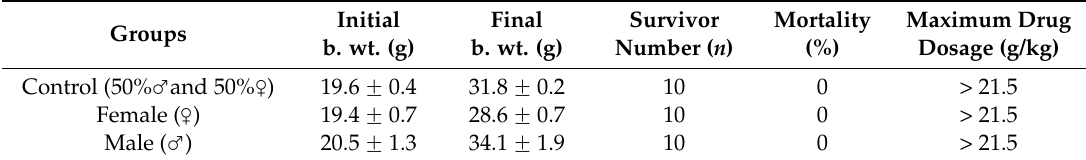
Table 1. Effects of GBP on body weight in mice (x ˘ s, n = 10).